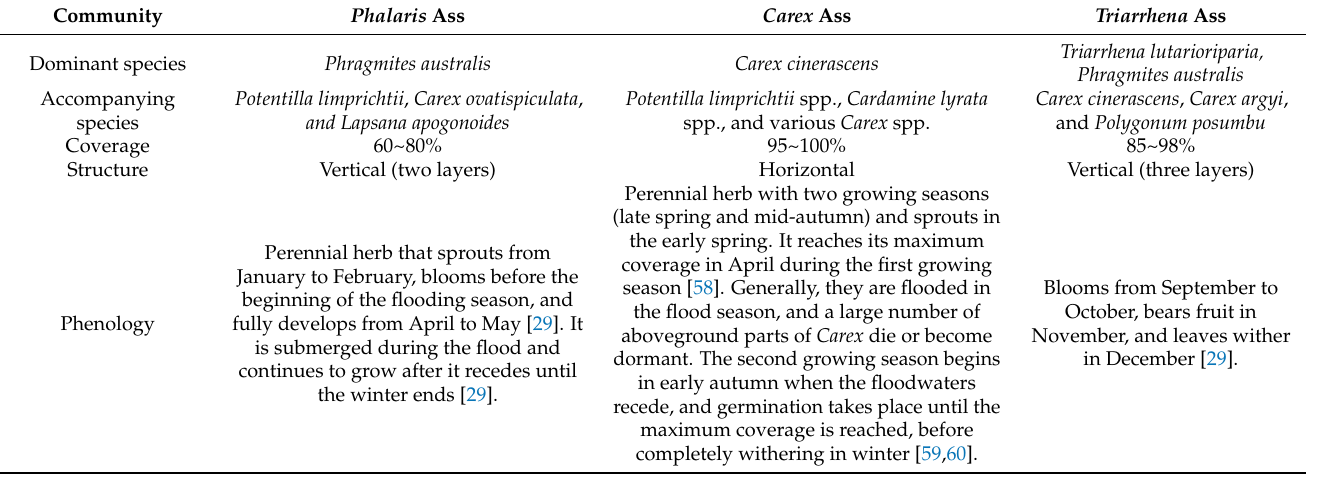
Table 1. Summary of the dominant species and their phenology for the three plant